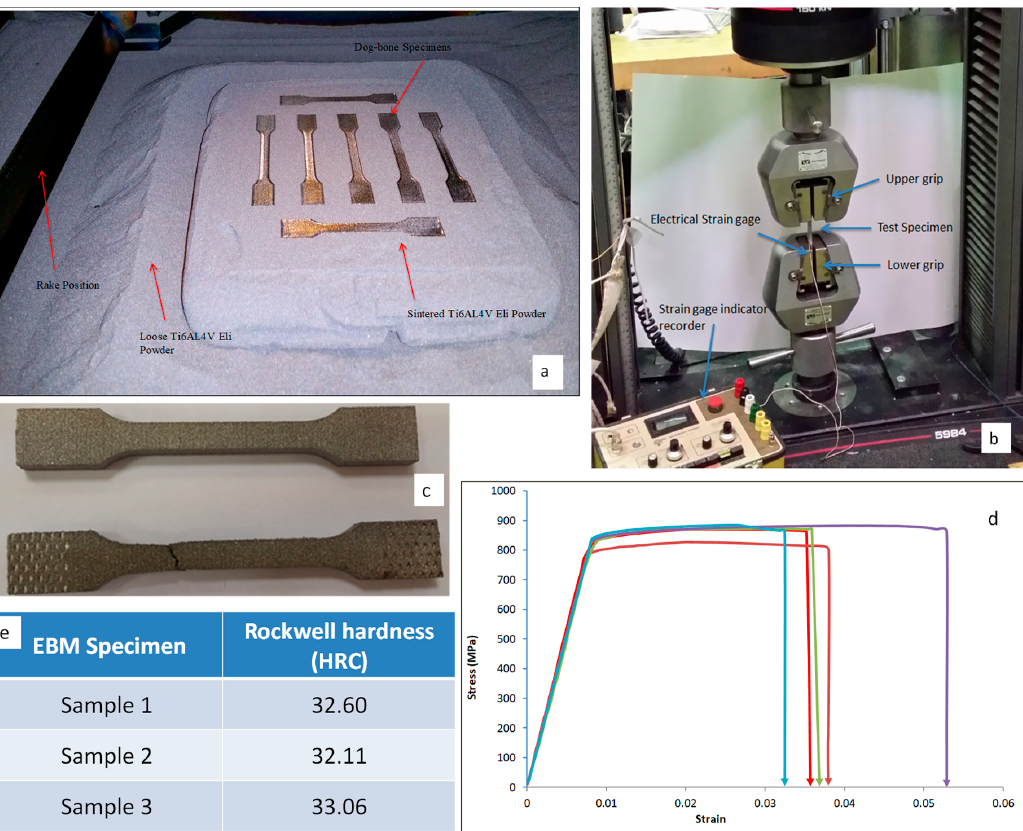
Figure 14. ( a ) EBM produced dog bone shaped specimen; ( b ) Tensile test on an Instron 2716 series machine; ( c ) EBM produced titanium tensile specimens before and after the test; ( d ) Tensile stress-strain relationship curve for test specimens and ( e ) Rockwell hardness measurement (HRC) results.